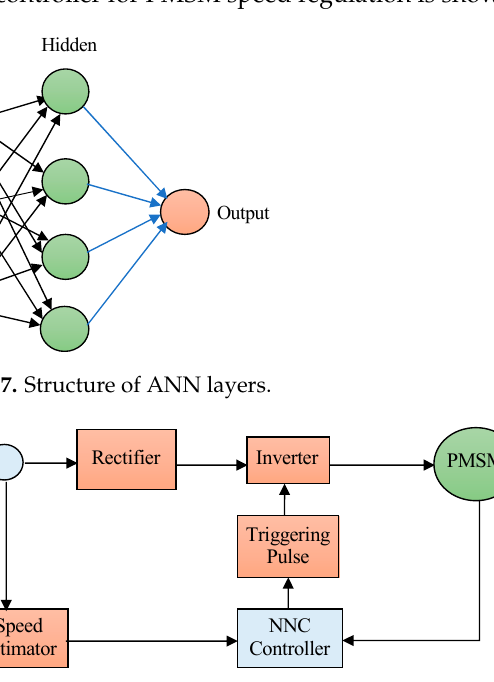
Figure 8. Basic structure of the PMSM NNC control.